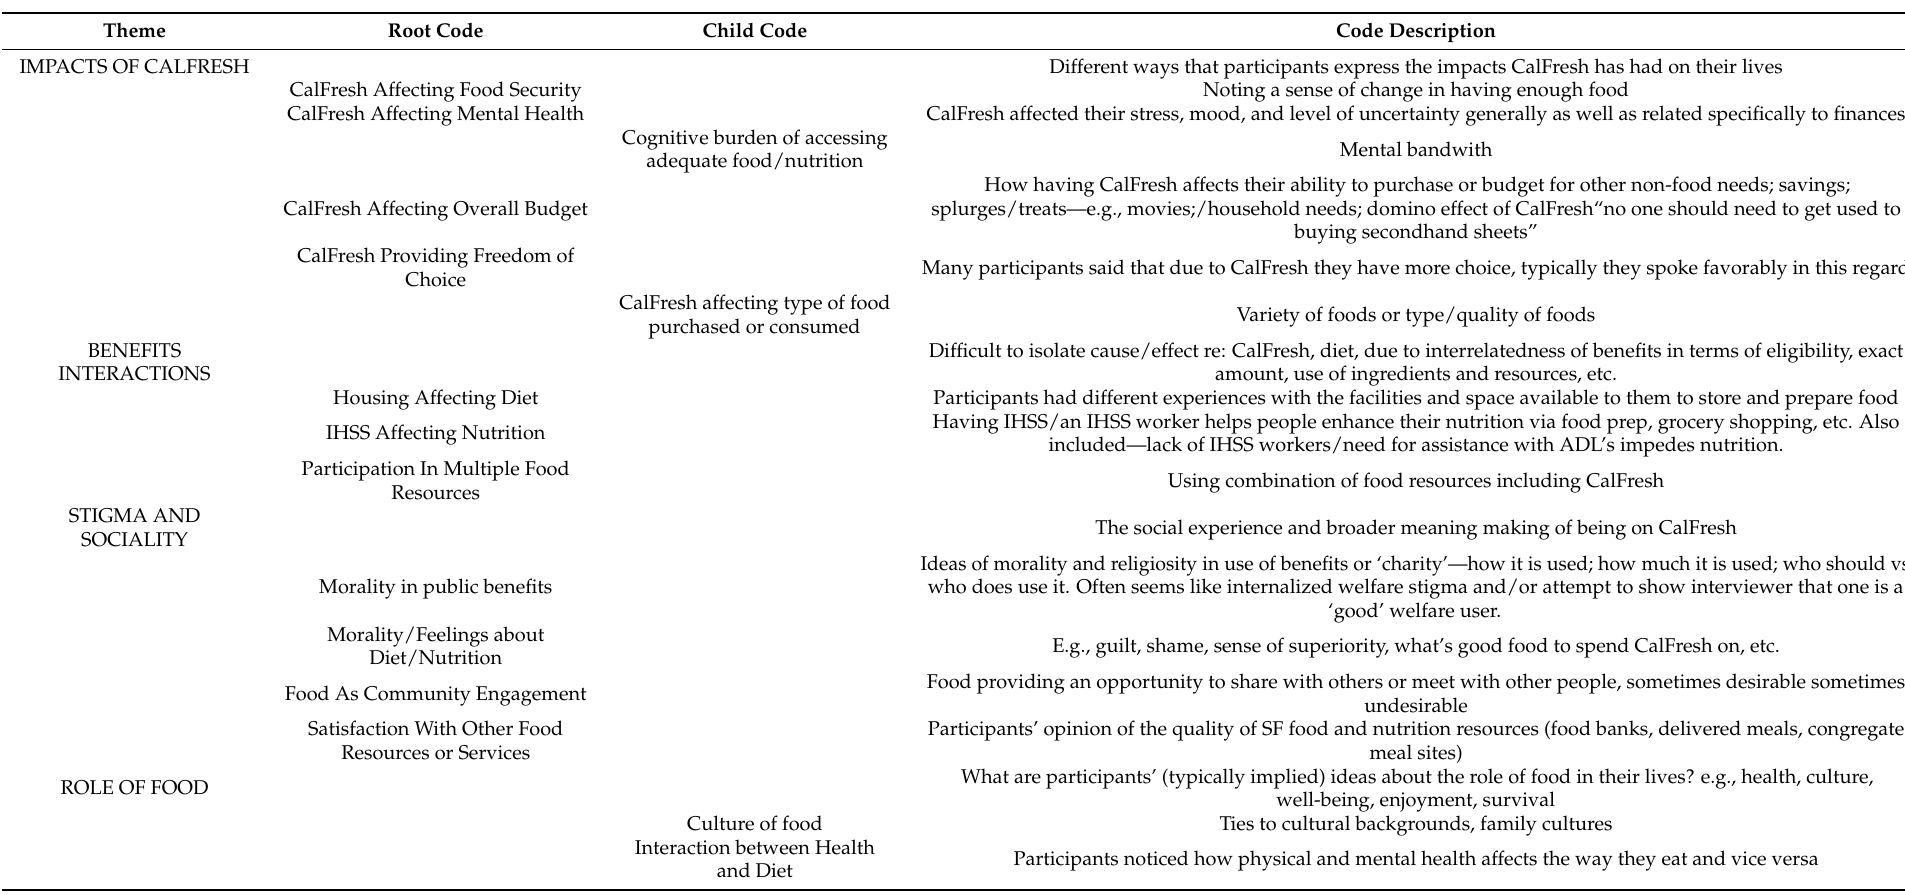
Table A1. Thematic Analysis Coding